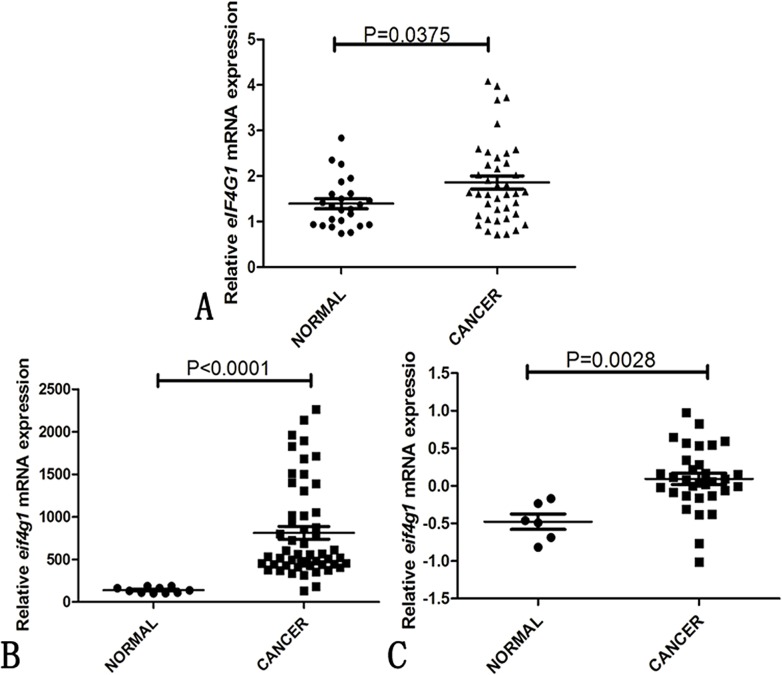
The mRNA expression of eIF4G1 in ovarian cancer tissues and normal ovary epithelial cell specimens.(A) Real-time RT PCR analysis of eIF4G1 in fresh frozen ovarian cancer samples and normal ovarian surface epithelial cell specimens in our study (P = 0.0375). (NORMAL:27 normal ovarian surface epithelial cell specimens;CANCER:40 frozen ovarian cancer samples). (B) Relative eIF4G1 mRNA expression of ovarian cancer samples and normal ovarian surface epithelial cells from the reported microarray data (accession number GSE18521) (P<0.0001; NORMAL: 10 normal ovarian tissues; CANCER: 53 snap-frozen ovarian cancer tissue specimens). (C) Relative eIF4G1 mRNA expression of ovarian cancer samples and normal ovarian surface epithelial cells from reported microarray data (accession number GSE40595; P = 0.0028; NORMAL: 6 normal ovarian surface epithelial cells; CANCER: 35 snap-frozen ovarian cancer tissue specimens). Scatter plot represents means ± SD.